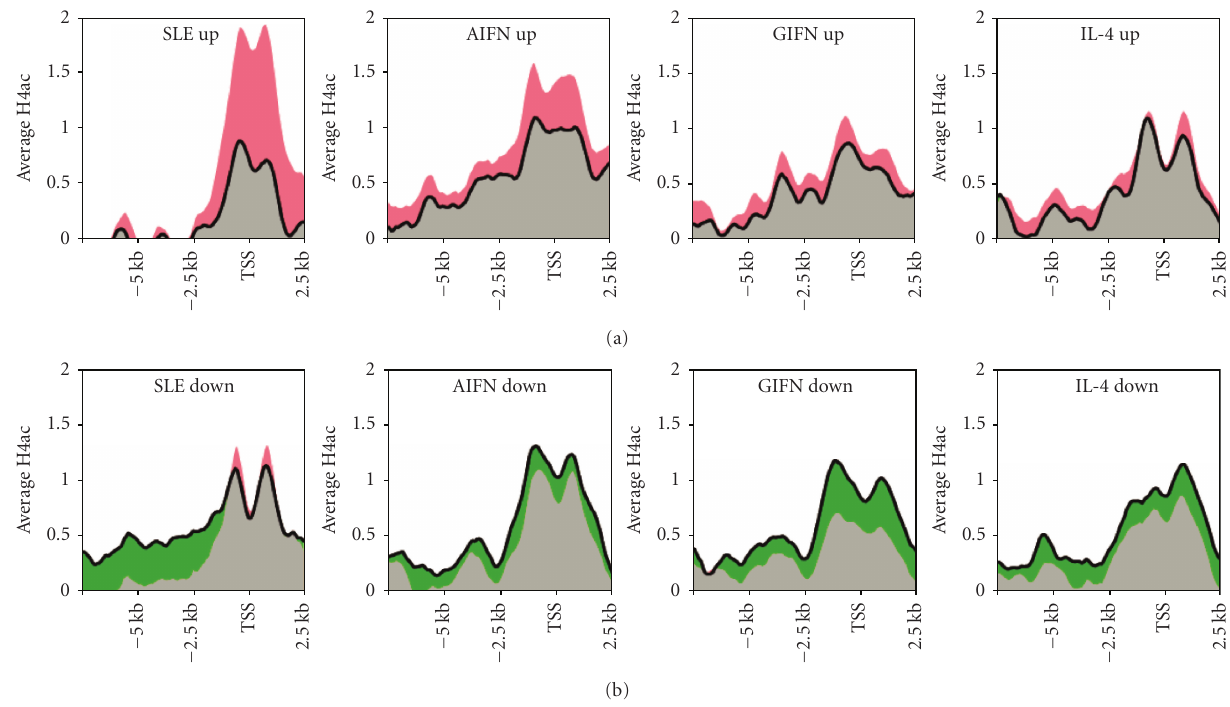
Figure 6: The change in gene expression in SLE or cytokine-treated samples was matched by H4ac changes in the same samples. (a) Upregulated genes seen in SLE or after cytokine treatment were examined for H4ac content. The top 200 genes with the highest expression change caused by SLE or cytokines, as was identified by previous analysis were included. (b) Down-regulated genes seen in SLE or after cytokine treatment were examined for H4ac content. The 200 genes most down-regulated were examined. The black contour indicates the average H4ac in control samples and the colored regions correspond to the amount of H4ac increase (red) or decrease (green) in SLE or cytokine-treated samples. Table 3: Concordance between gene expression and H4ac